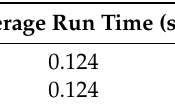
Table 7. Comparison of the